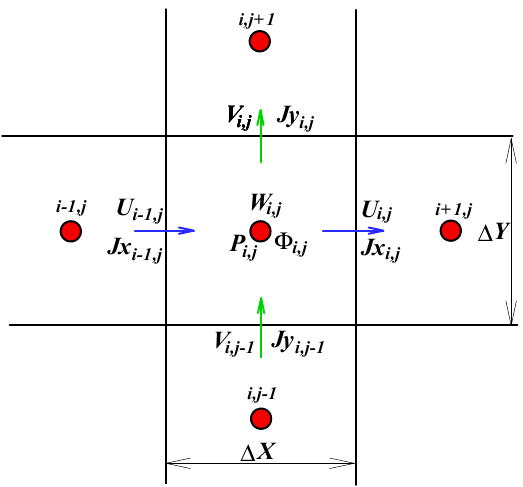
Figure 2. The equidistant staggered mesh system employed in the computations of basic and disturbance equations. The variables such as pressure and electric potential are defined at the cell-centers indicated with red points, while the vector components are defined at the cell-interfaces indicated with blue and green arrows.